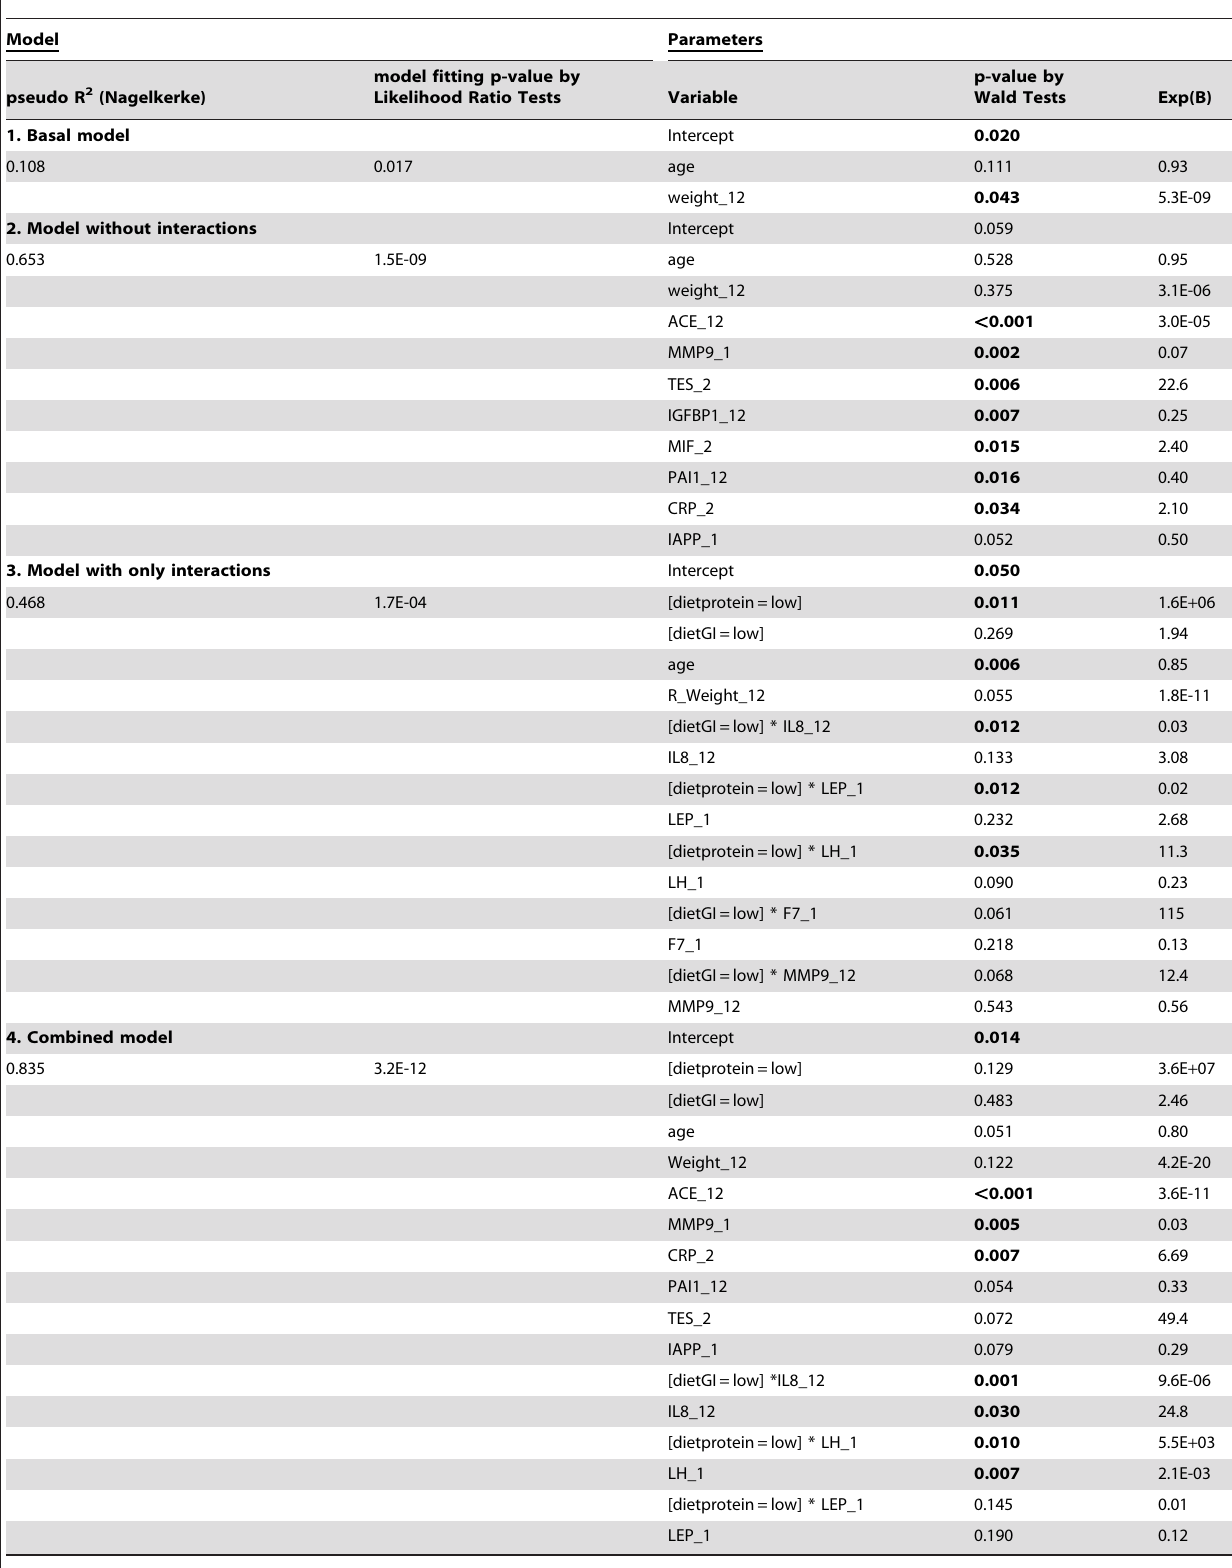
Table 3. Logistic regression models to predict continued weight loss during the 6-month maintenance